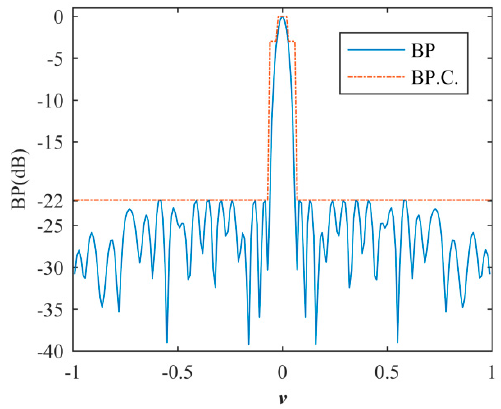
Figure 5. Beam pattern (BP) constraints.